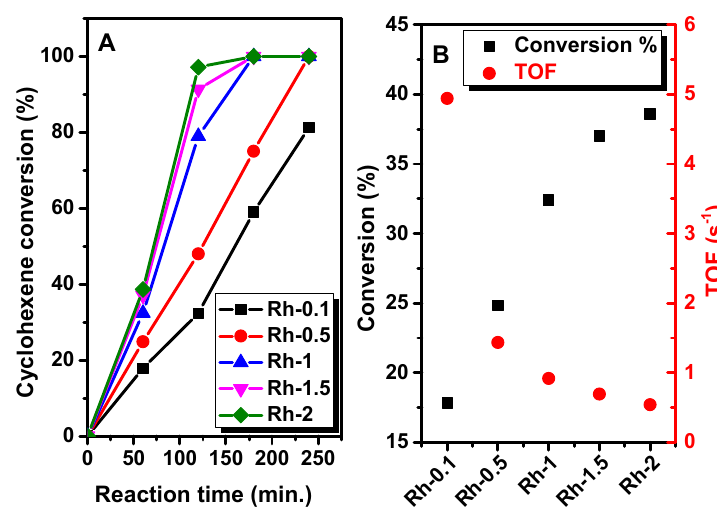
Figure 6. ( A ) The conversion profiles of cyclohexene reduction over different Rh-TUD-1 samples within 4 h of reaction. ( B ) The obtained conversion of cyclohexene and the corresponding TOF (s − 1 ) after 1 h of reaction.